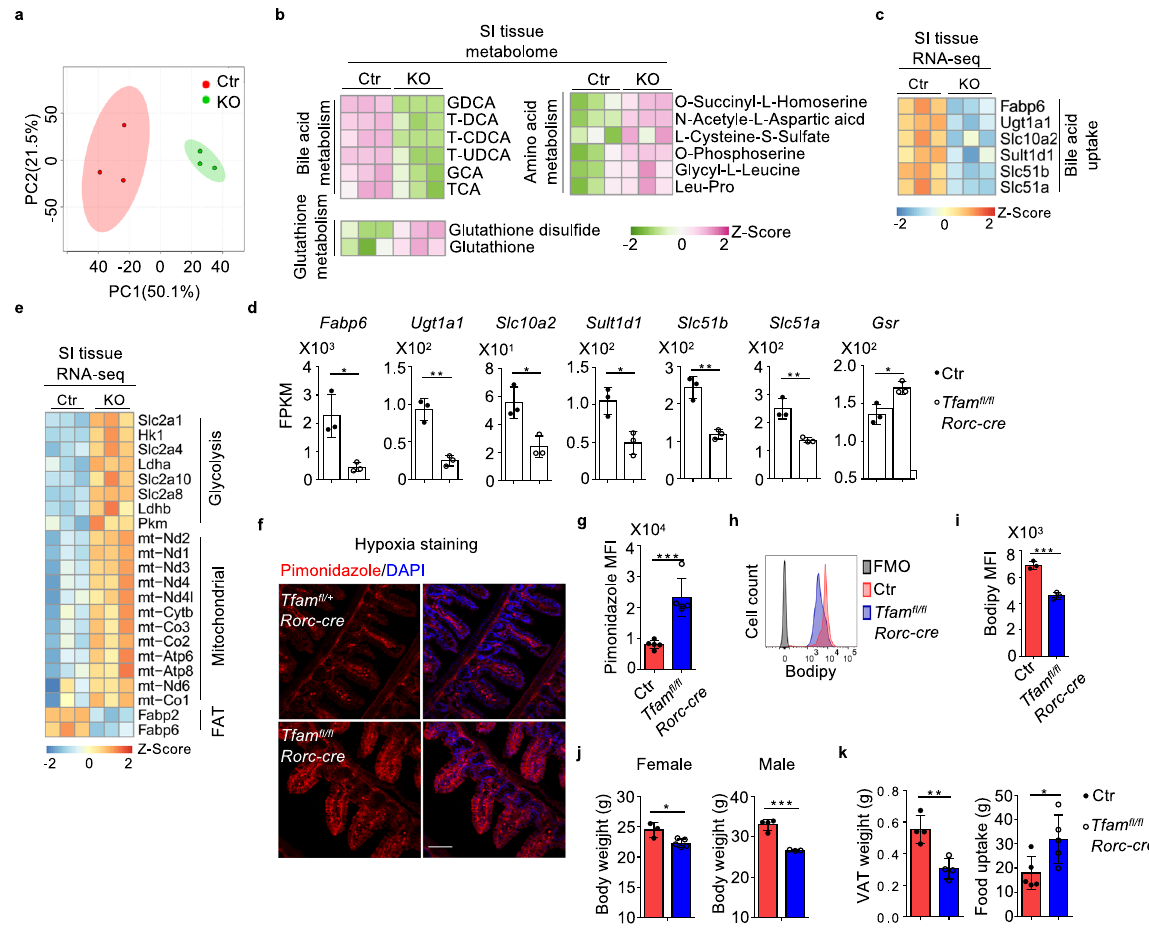
Fig. 7 Tfam deletion in ROR γ t + lymphocytes lead to global metabolomic changes in the small intestine. Ctr included Tfam + / + Rorc-cre and Tfam fl / + Rorc- cre mice, while KO indicated Tfam fl / fl Rorc-cre mice in a – e . a PCA analysis of the metabolome of small intestine tissues of 12-week-old Ctr and KO mice ( n = 3 for each group). Each group included three individual mice. b Heatmap of the differentially regulated metabolites between small intestine tissues of Ctr and KO groups identi fi ed by the metabolome analysis. Metabolites were ranked in a descending order based on the fold changes of abundance (Ctr/KO; KO/Ctr). c Heatmap of indicated gene expression of small intestine tissue RNA-seq of Ctr and KO mice as shown in Fig. 5a. Genes were ranked in a descending order based on the fold changes of expression (Ctr/KO). d RNA-seq FPKM values of indicated genes in small intestine tissues of the mice ( n = 3) ( Fabp6 , * P = 0.0155; Ugt1a1 , ** P = 0.0019; Slc10a2 , * P = 0.0162; Sult1d1 , * P = 0.0158; Slc51b , ** P = 0.0027; Slc51a , ** P = 0.0066; Gsr , * P = 0.0186). e Heatmap of DEGs in small intestine tissues of the mice identi fi ed by RNA-seq ( n = 3). Genes were ranked in a descending order based on the fold changes of expression (KO/Ctr). Ctr included Tfam + / + , Tfam fl / + , Tfam fl / fl , Tfam + / + Rorc-cre , and Tfam fl / + Rorc-cre mice in g – k . f Confocal analysis of hypoxia by pimonidazole staining in the small intestine (ileum) of 12-week-old mice with indicated genotypes. Red, pimonidazole staining. Blue, DAPI staining. Scale bar, 200 µ m. Representative data of three independent experiments. g Pimonidazole MFI in the epithelial cells shown in f ( n = 5 for each group) (*** P = 0.0006). Compiled data from one experiment. h Bodipy uptake in small intestine epithelial cells from Ctr and Tfam fl / fl Rorc-cre mice measured by fl ow cytometry. Representative data of two independent experiments. i Bodipy MFI in the epithelial cells as shown in h ( n = 3 for each group) (*** P = 0.0006). Compiled data from one experiment. j Body weight of 5-month-old female Ctr ( n = 3) and Tfam fl / fl Rorc-cre mice ( n = 5) and male